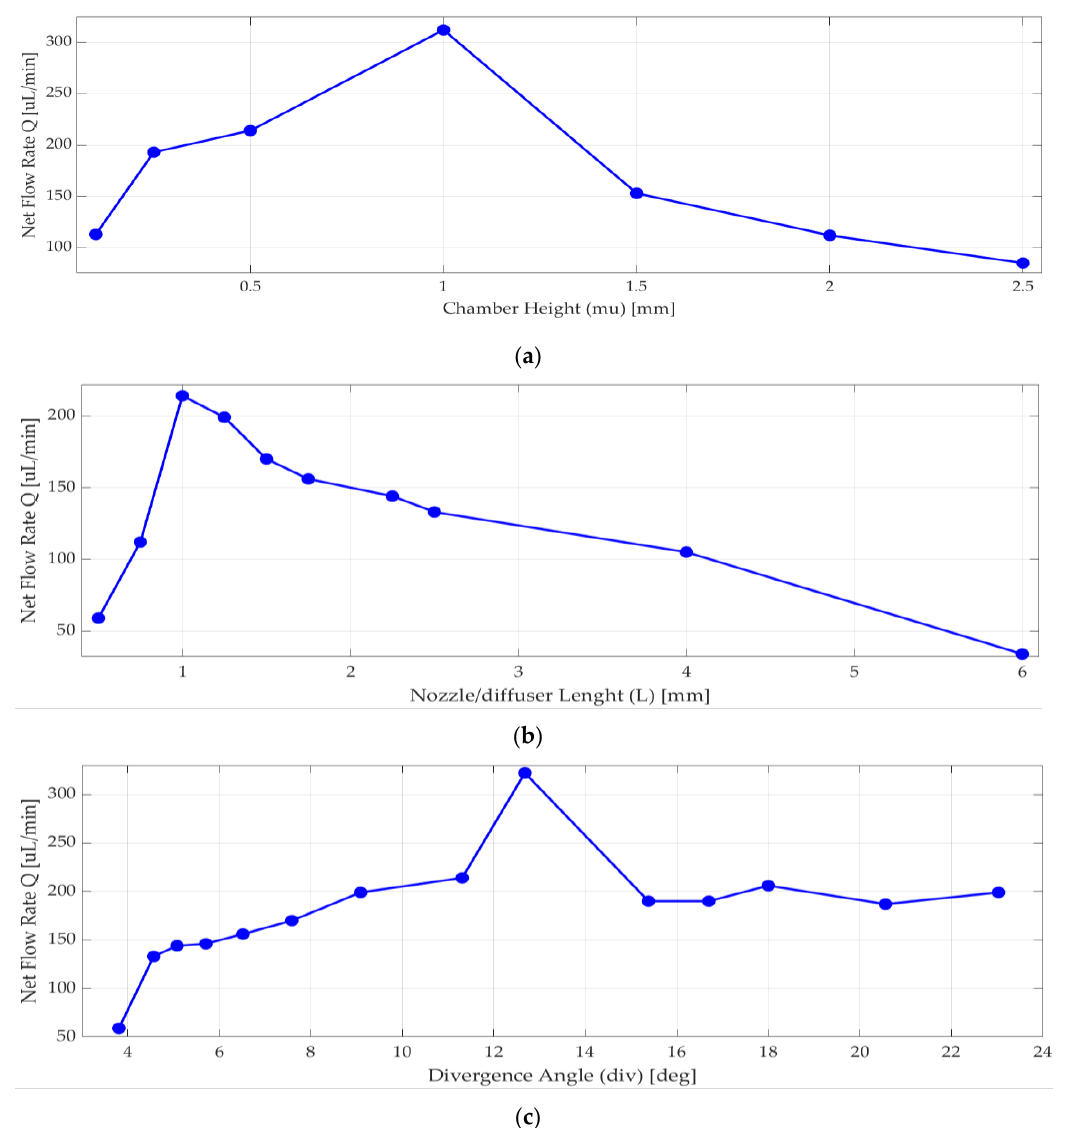
Figure 4. Numerical simulation results for net flow rate versus ( a ) chamber height; ( b ) length of nozzle/diffuser, ( c ) divergence angle.